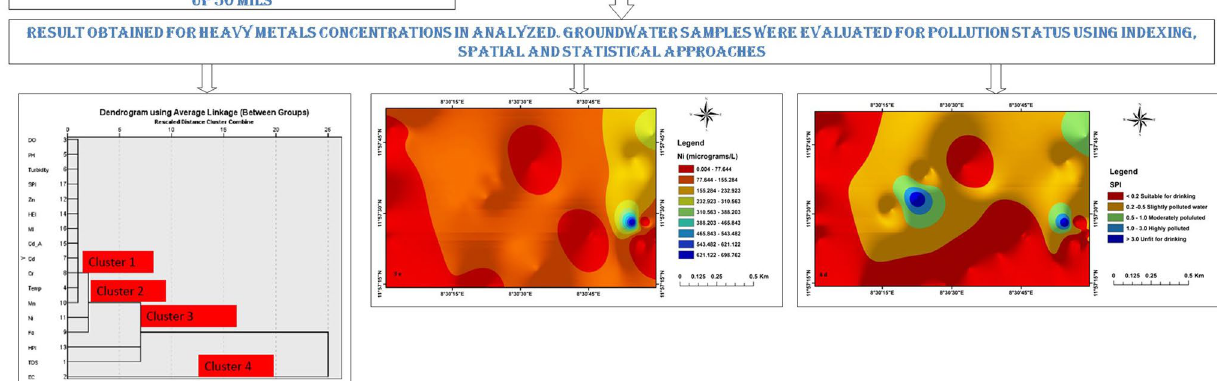
Fig. 2 A flowchart showing all the methods used in the present